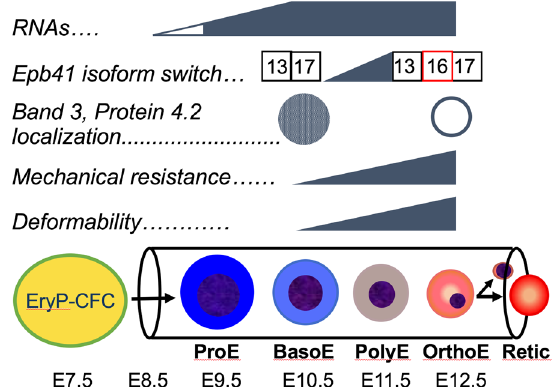
Figure 6. Model of kinetics of membrane skeleton network formation in primary primitive erythroblasts. Primary primitive erythroblasts progressively and synchronously mature between E9.5 and E12.5 in the bloodstream of the mouse embryo prior to enucleating. The expression of the major cytoskeletal genes found in definitive red blood cells has already initiated in primary primitive proerythroblasts (ProE) at E9.5. The cytoskeletal proteins β 1-spectrin, band 3, and protein 4.2 transition to the plasma membrane at late stages of erythroblast maturation concomitant with the alternative splicing of Epb41 exon 16. This transition is associated with significant increases both in the association of the cytoskeleton to the lipid bilayer and in cell deformability. BasoE- basophilic erythroblast, PolyE- polychromatophilic erythroblast, OrthoE- orthochromatic erythroblast, Retic-